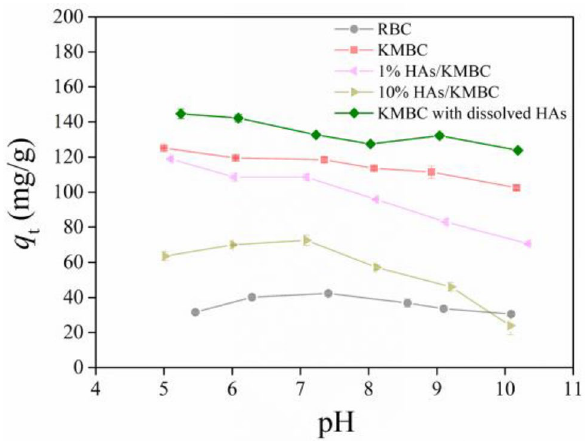
Figure 5. Effects of pH on TC adsorption by RBC, KMBC, dissolved HAs and coated HAs modified KMBC. C